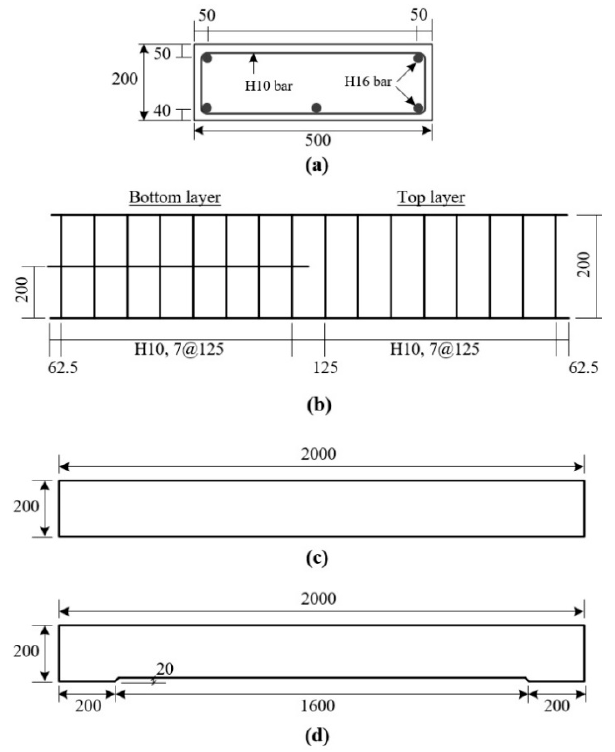
Figure 9. RC slab specimen: ( a ) cross-sectional dimensions; ( b ) reinforcement details; ( c ) side view of RC specimen; side view of RC slab to be strengthened with TRC panel; and ( d ) side view of RC slab with indented